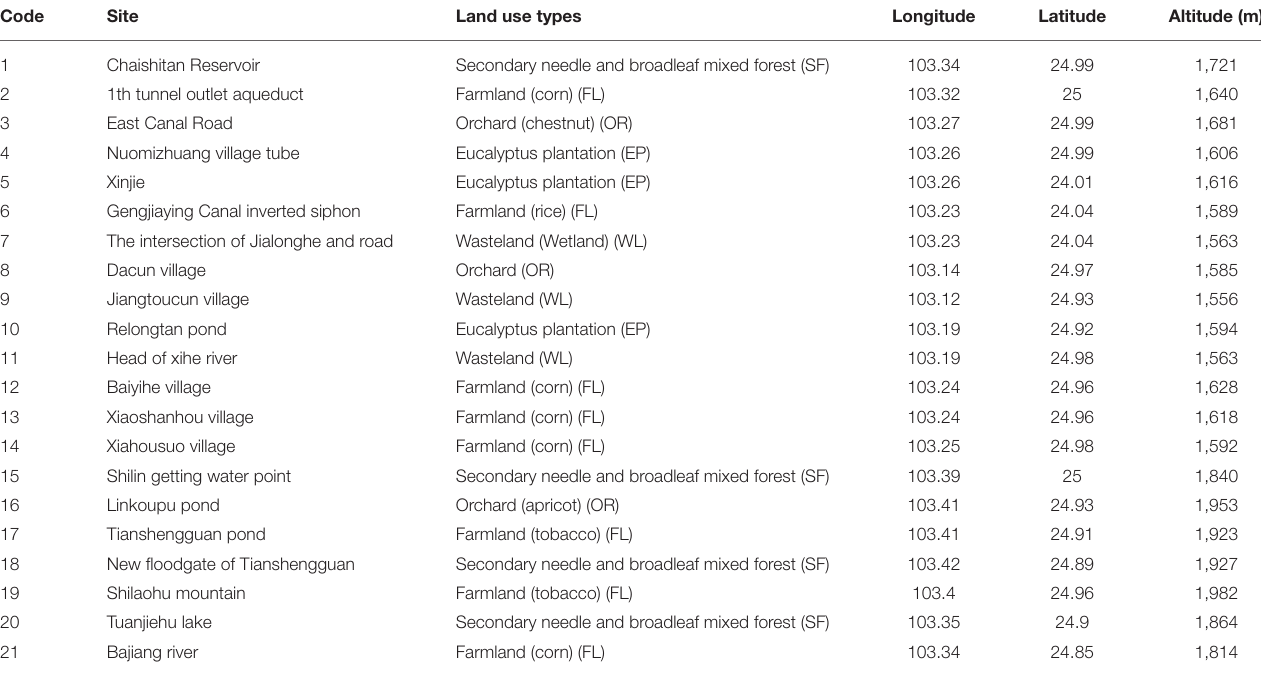
TABLE 2 | Plant community sampling sites in Chaishitan irrigation region, Yunnan province of China.